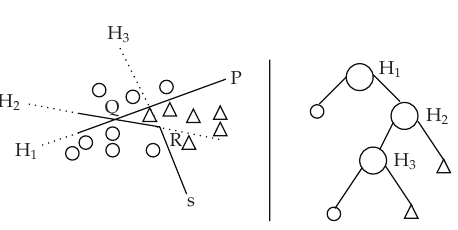
Figure 2: One particular type of SPS tree for D (cid:8)